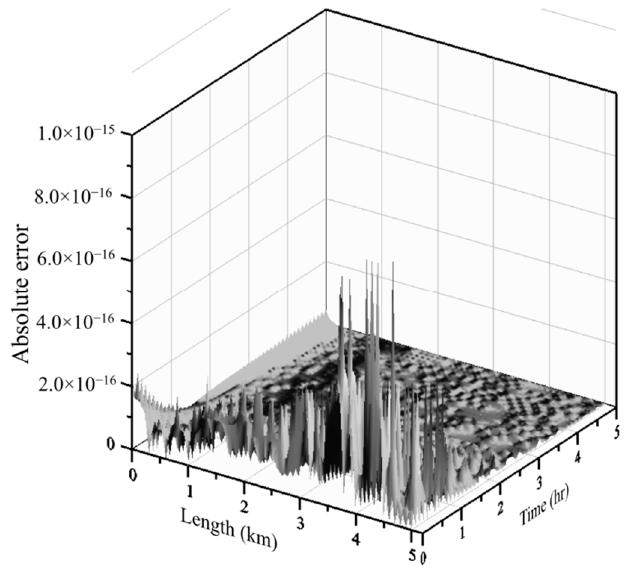
Figure 5. Absolute error of the results computed with the analytical solution at the final time.